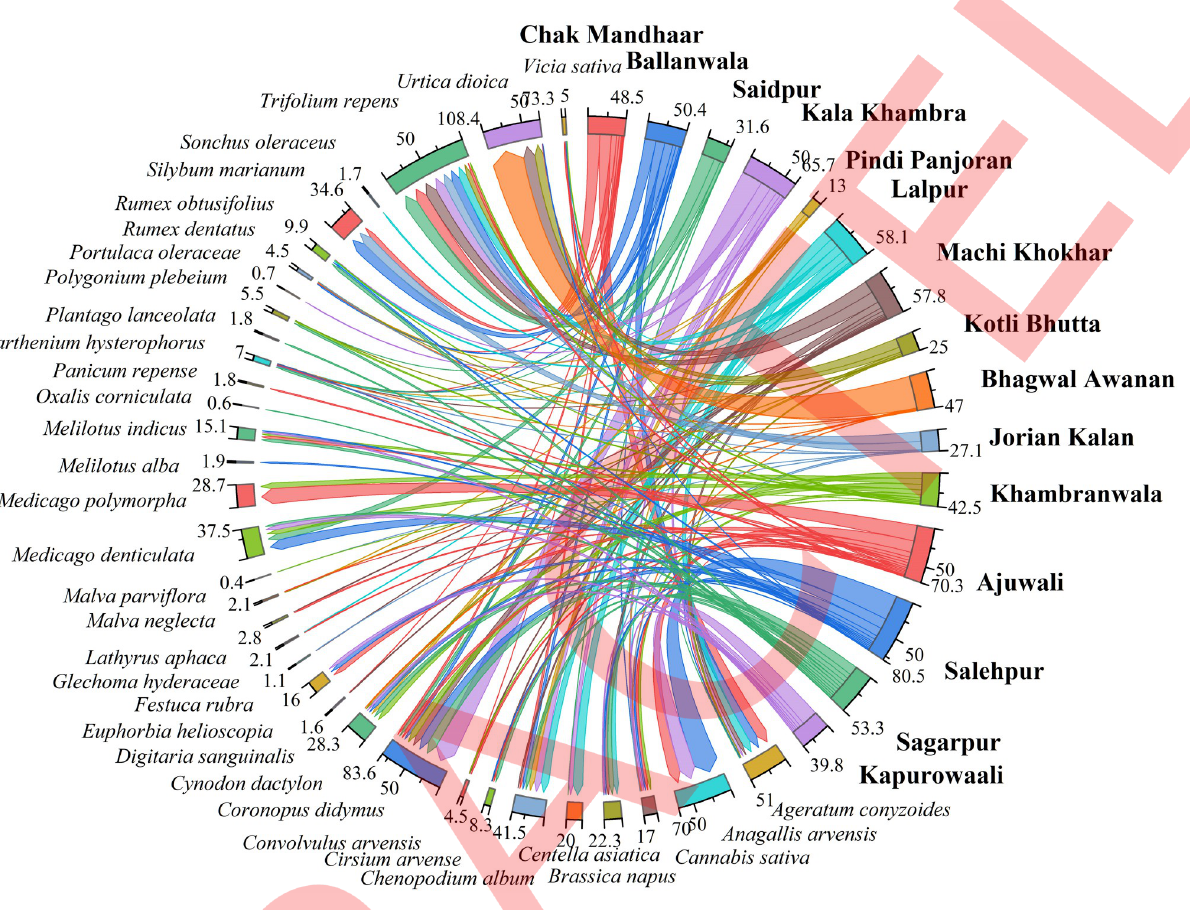
Fig 2. Chord diagram representing the density of recorded weed species in fifteen different wheat fields of Sialkot.